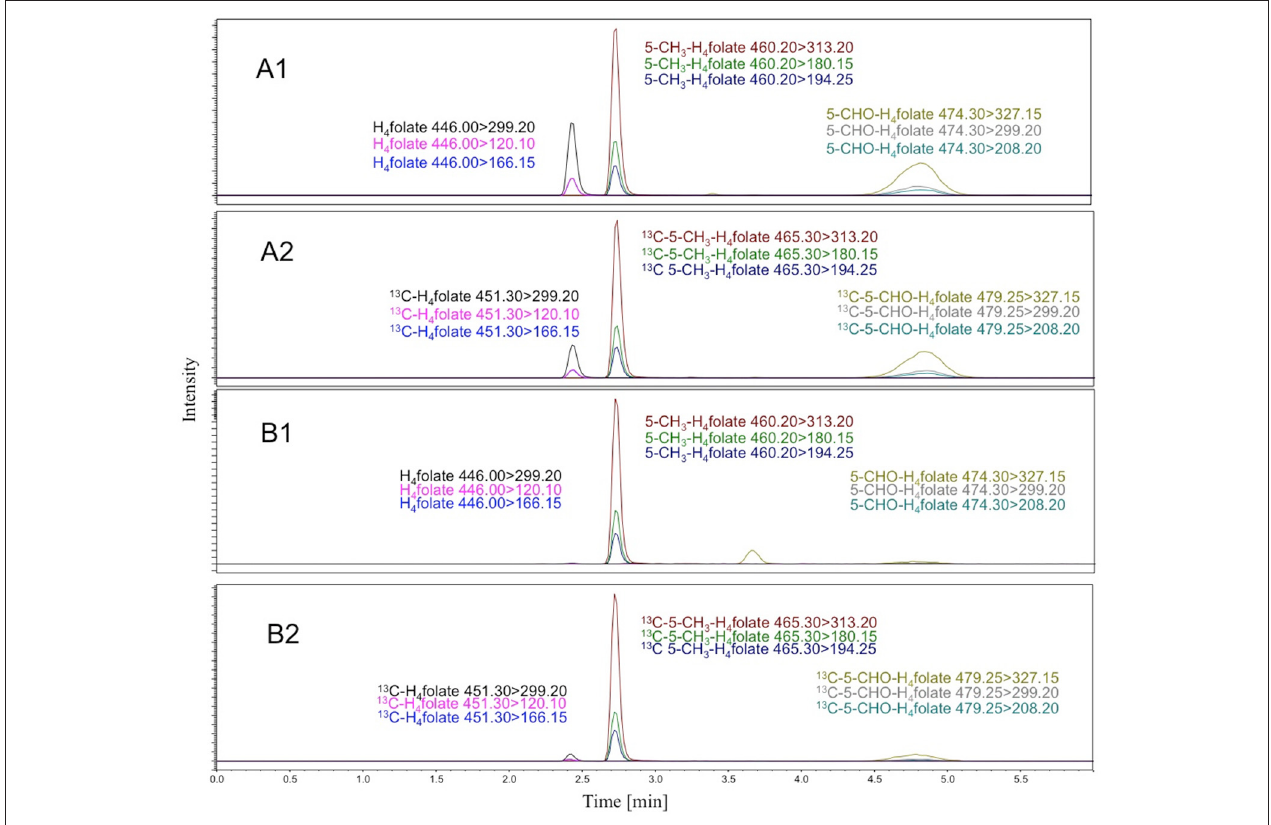
FIGURE 2 | LC-MS/MS-chromatogram of a strawberry sample ( B1 : MRMs for analytes; B2 : MRMs for internal Standards) and the response run of pure analyte-internal standard mixtures ( A1 : MRMs for analytes; A2 : MRMs for internal Standards).